Question: Name the type of graph shown.
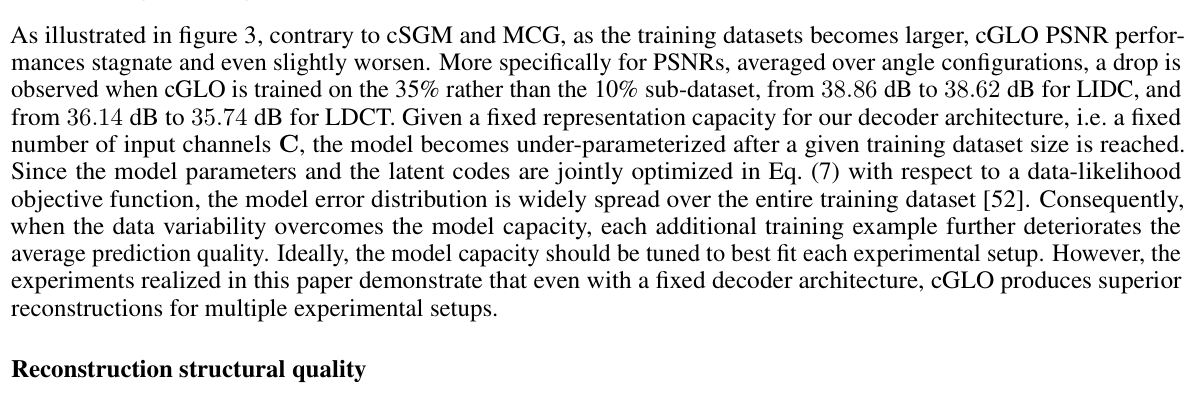
Answer: line